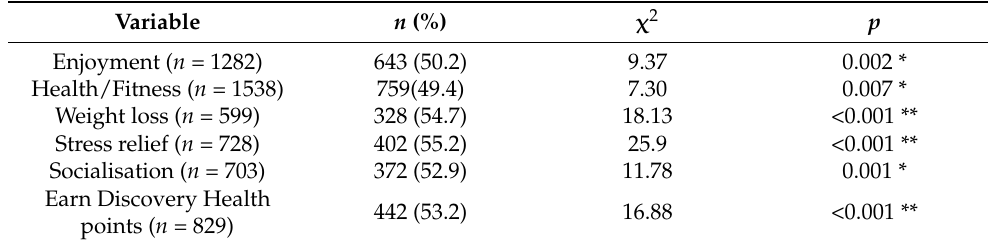
Table 4. Association between motivation for parkrun participation and uptake of physical activity post- parkrun